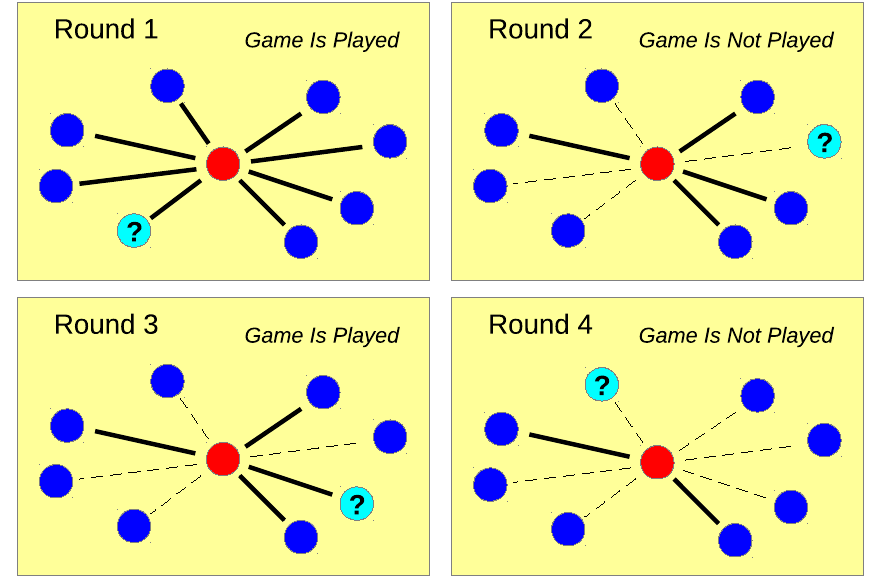
Figure 1. Schematic illustrating indirect reciprocity with optional interactions and private information in a population with eight cooperators (blue) and a single defector (red). The population size is N = 9 . The defector is at the center of each image of the population. Each solid black line connecting the defector with a cooperator represents an active link. In the first round, the defector is offered a game with a random cooperator (light blue with a “?”), and the game is played. The defector gains payoff b . Each of the defector’s links is removed with probability p = 0 . 5 . After the first round, four of the defector’s links with cooperators are eliminated (thin dotted lines). In the second round, the defector is offered a game with a cooperator that knows the defector’s identity, so the potential game is rejected. In the third round, the defector again exploits an ignorant cooperator, and the defector again receives payoff b . Two of the remaining active links are eliminated. In the fourth round, the defector is offered a game with an informed cooperator, and the potential game is rejected. After this sequence of four rounds, the defector gains total payoff 2 b